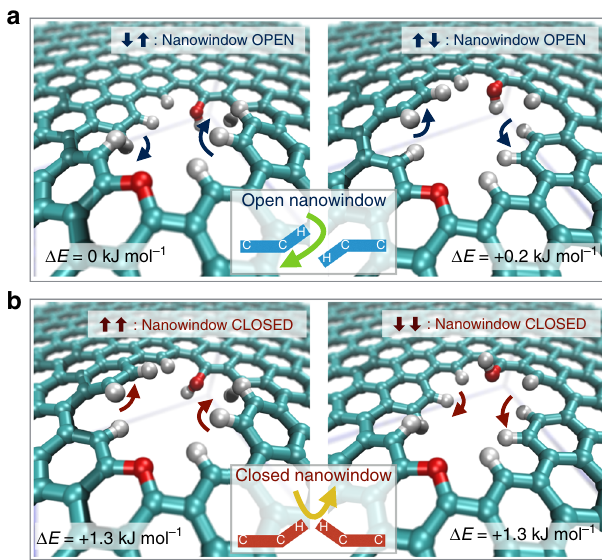
Fig. 5 Functional group fl apping mechanism in a small nanowindow. The nanowindow can be in an open or closed states for allowing O 2 permeation. a Open states. Pairs of hydrogen point in different directions. b Closed states. Pairs of hydrogen point in the same direction. Arrows indicate the directions where the H-pairs point. Energy difference is respective to the structure a , left. Cyan, red, and white atoms are C, O, and H, respectively. Insets illustrate the equivalence between fl apping movement and the opening/closing of gates. These fi gures correspond to O 2 permeation at 90 K through NW-2.73